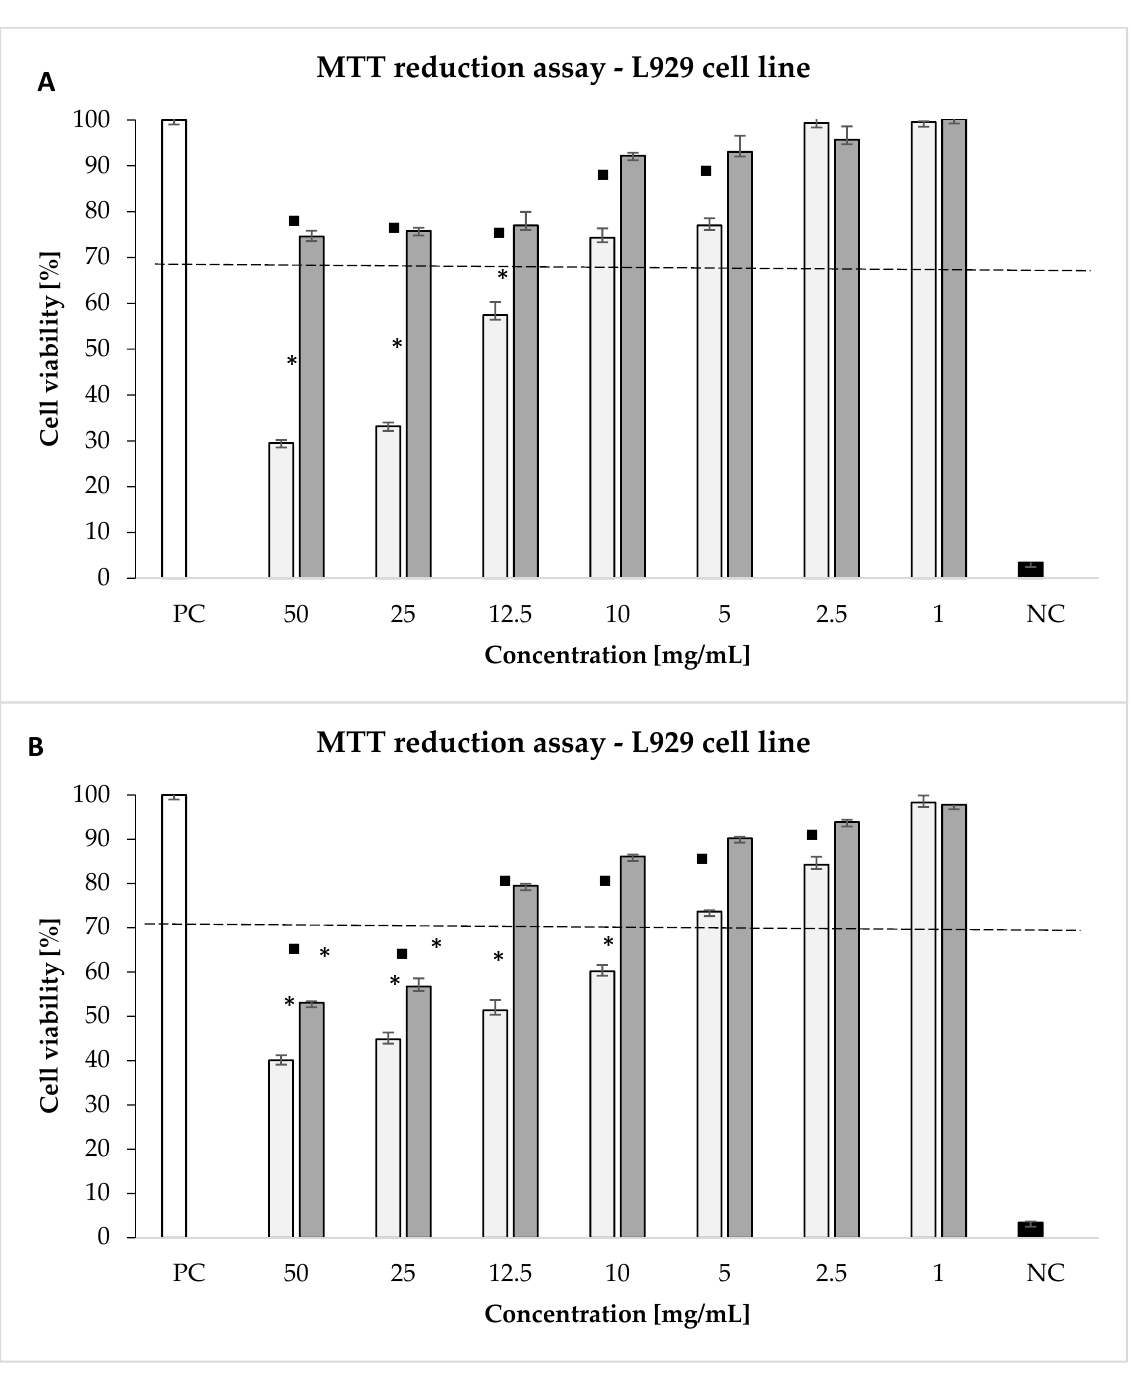
Figure 3. Cytotoxic effect of plants extracts: ( A ) thyme, ( B ) oregano towards L929 cells. The cytotoxicity was assessed by MTT [(3-(4,5-dimethylthiazol-2-yl)-2,5-diphenyltetrazolium bromide)] reduction assay. The cell viability was calculated for four experiments, including three repeats for each compound. Complete RMPI-1640 medium (cRPMI) was used as a positive control (PC) of cell viability (100% viable cells) and 0.03% H 2 O 2 as a negative control (NC) of cell viability (100% dead inactive cells). Statistical significance: * p < 0.05; * untreated cells vs cells treated with tested plants extracts “conventional” extract (light grey bars) vs “organic” extract (dark grey bars).